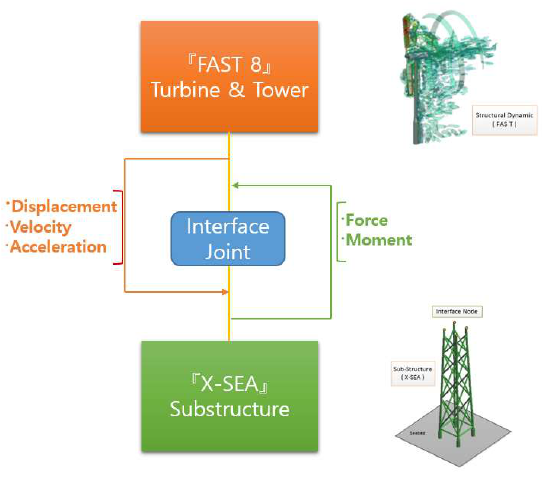
Figure 2. Basis layout of the structure module within X-SEA.